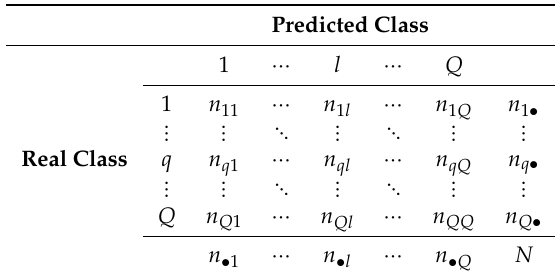
Table 1. Confusion matrix to evaluate the output of a classifier g using a dataset categorized into Q